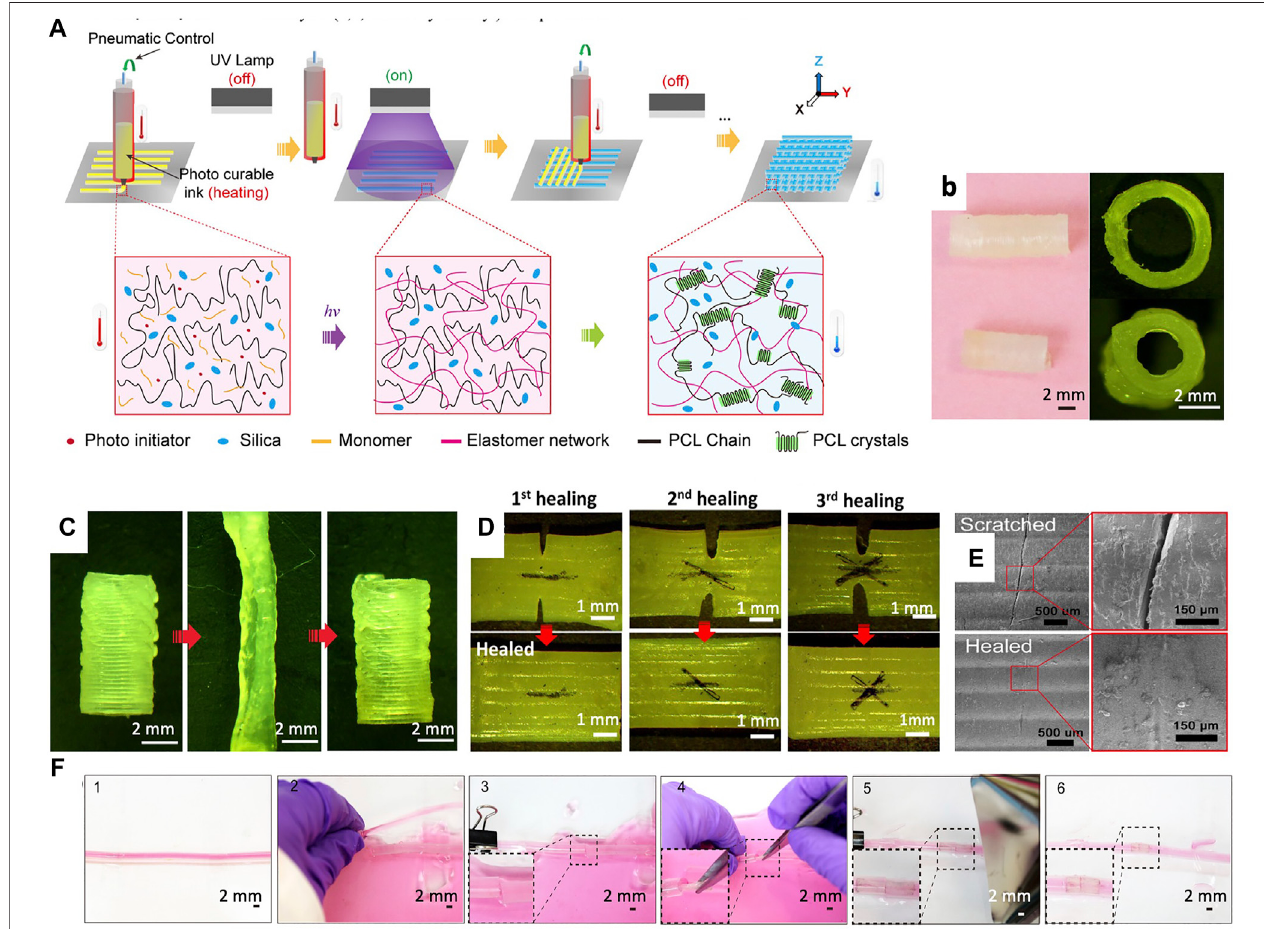
FIGURE 3 | Fabrication steps and investigations of 4D printed vascular grafts. (A) Schematic representation of the 3D printing of vascular grafts from UV curable compositeinkcomposedofcrystallinelinearchainandcrosslinkednetworkandthestructuralchangesduringthisprocess. (B) Photograph(left)andmicroscopicimage (right) of two different inner/outer diameters of printed vascular grafts with the same length of 10 mm. (C) Stretching and compressing of vascular conduits by thermal stimulationat70 ° C(abovePCLT m )tothetemporaryshapewithhalfoftheinitialdiameterandshaperecoveryaftercoolingdown(belowPCLT m ). (D) Threehealing cycles of the printed structures by cooling down in the air after heating at 80 ° C for 20 min (E) Scanning electron microscopy (SEM) observation of the scratched and healed part of the sample. (F) (1) The 4D printed blood vessel (2) was cut to be prepared for implantation. (3) By clamping the bleeding was stopped. (4) Implantation of the 4D printed graft in the crack region. (5) Shape recovery and attachment of the 4D printed graft to the vasculature by heating. (6) Blood circulation after vascular connection. Reproduced with permission of Kuang et al.